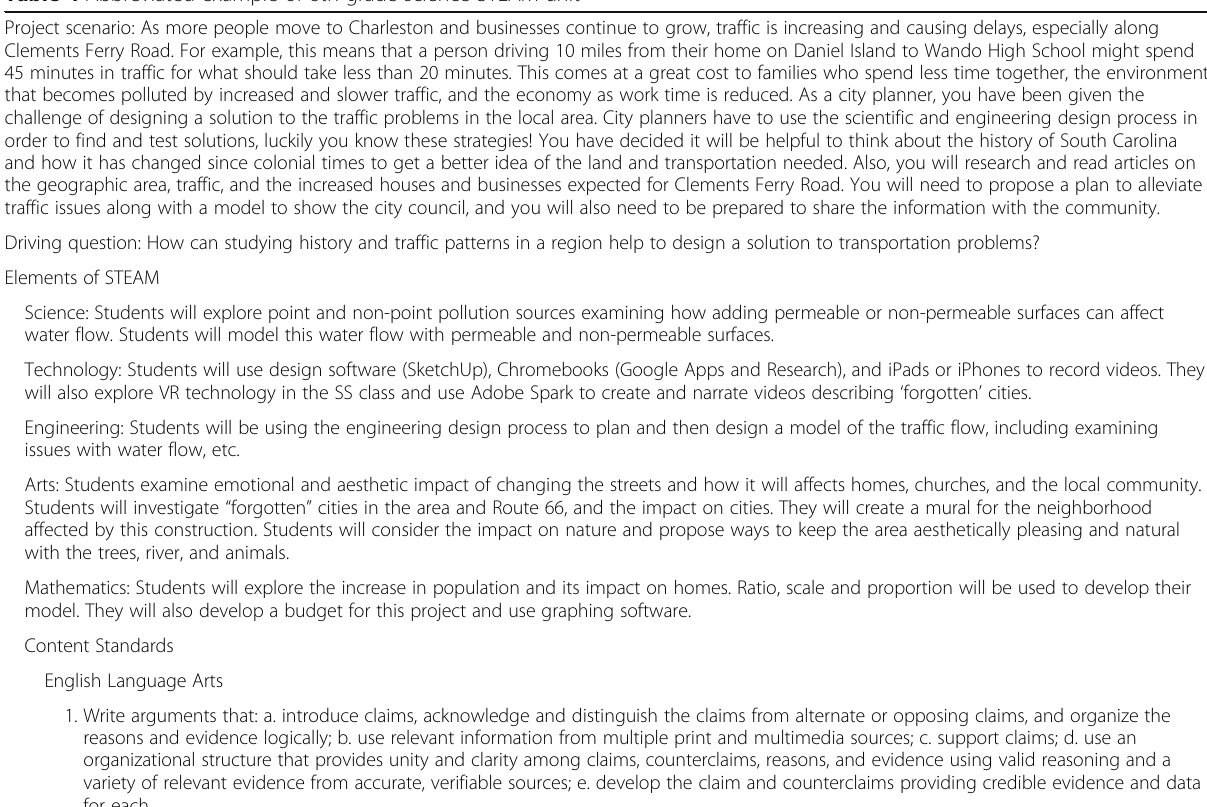
Table 4 Abbreviated example of 8th grade science STEAM